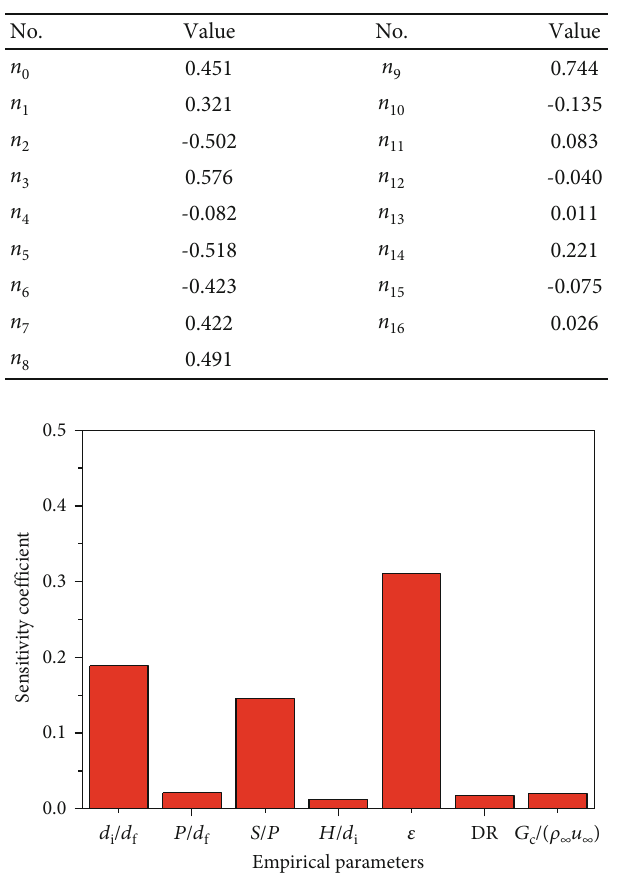
Figure 24: Sensitivity coe ffi cient of empirical